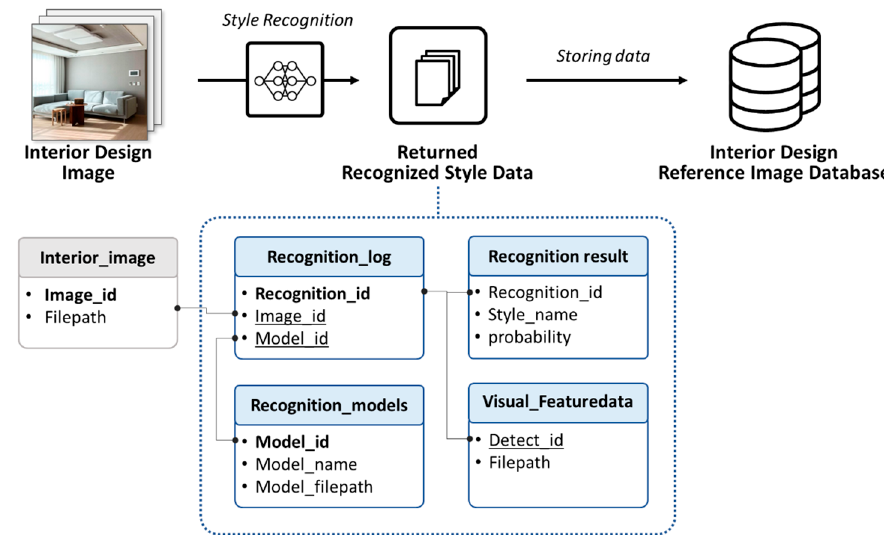
Figure 8. Establishing an interior design reference database with stochastic style data returned by the style recognition model.